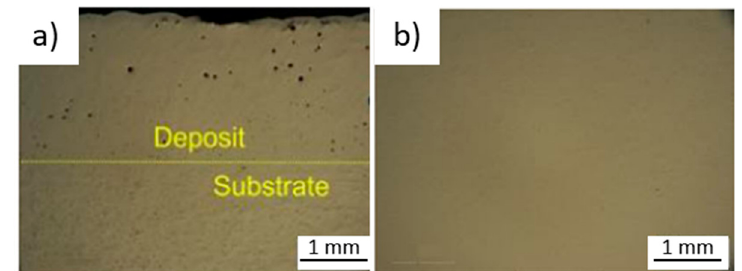
Figure 14. Porosity presence in samples manufacture with: ( a ) conventional cold metal transfer; ( b ) cold metal transfer-pulse advanced (adapted from [15]).